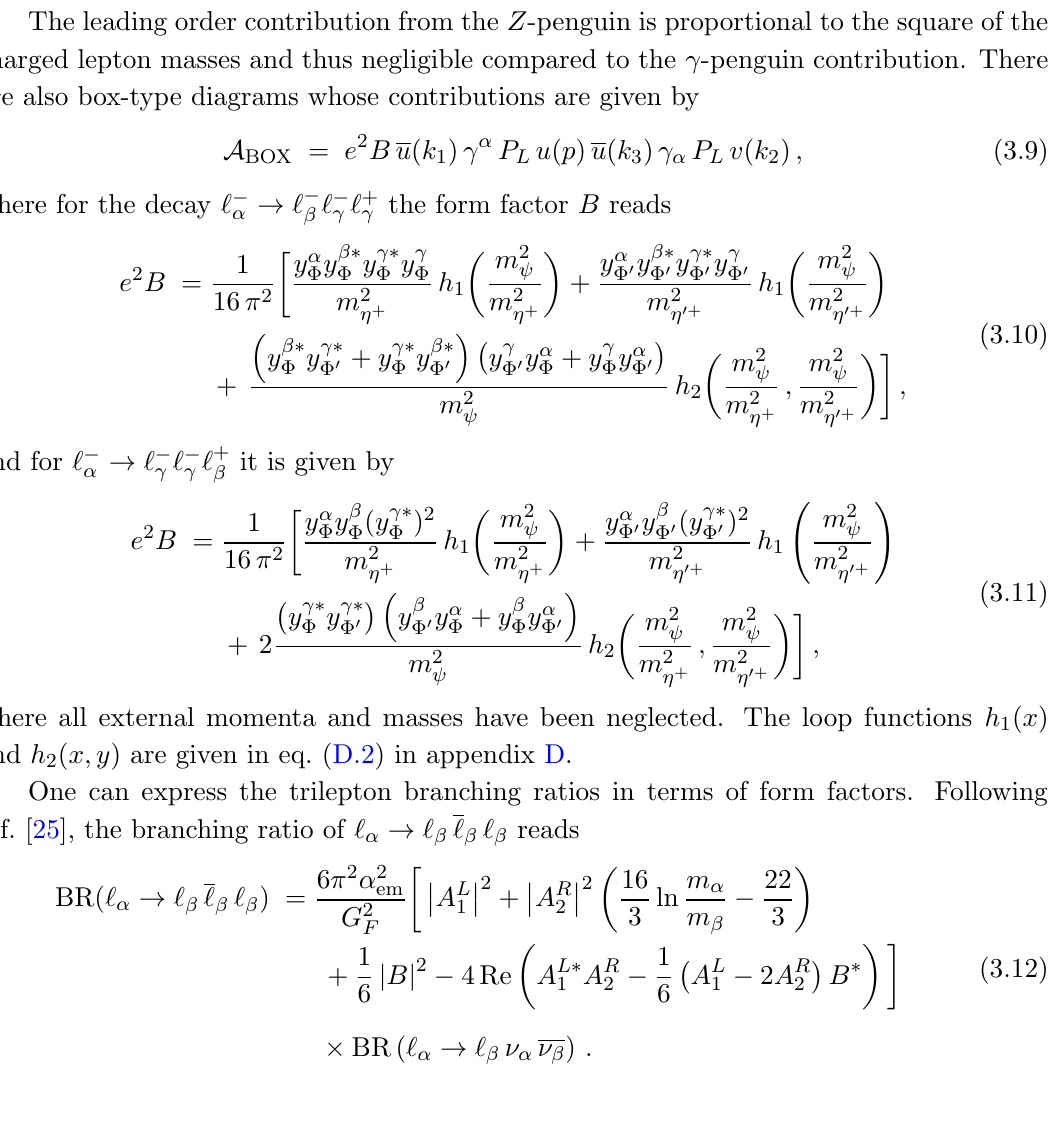
‘ (cid:12) (cid:22) ‘ (cid:13) ‘ (cid:13) !